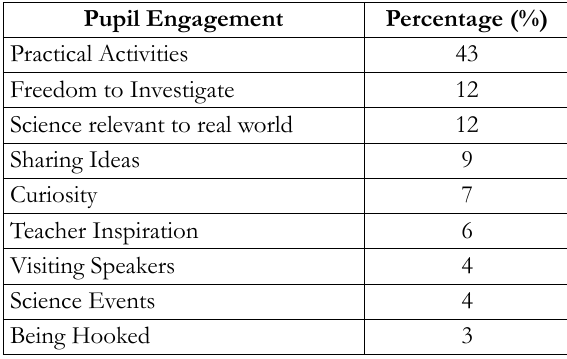
Table 5. Percentage of responses from teachers regarding motivating pupils (Questionnaire)